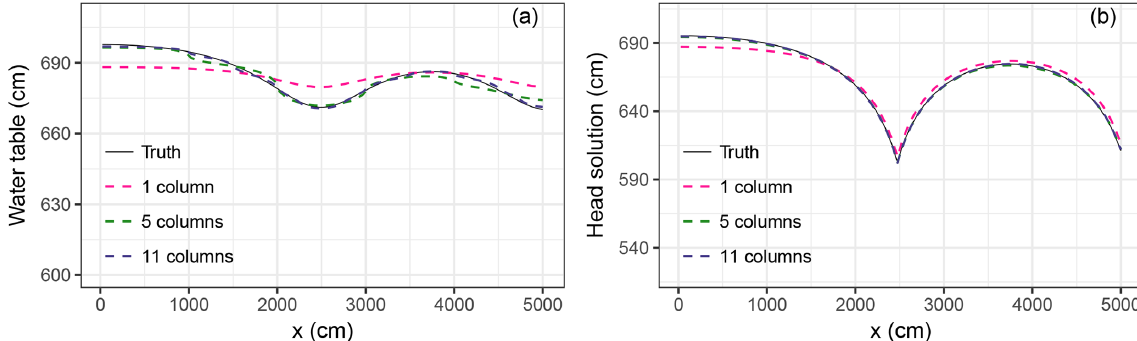
Figure 12. Comparison of (a) water table and (b) head solution (at z = 0) that are changing by the number of soil columns. Solutions obtained with a moving-boundary method in case 2.